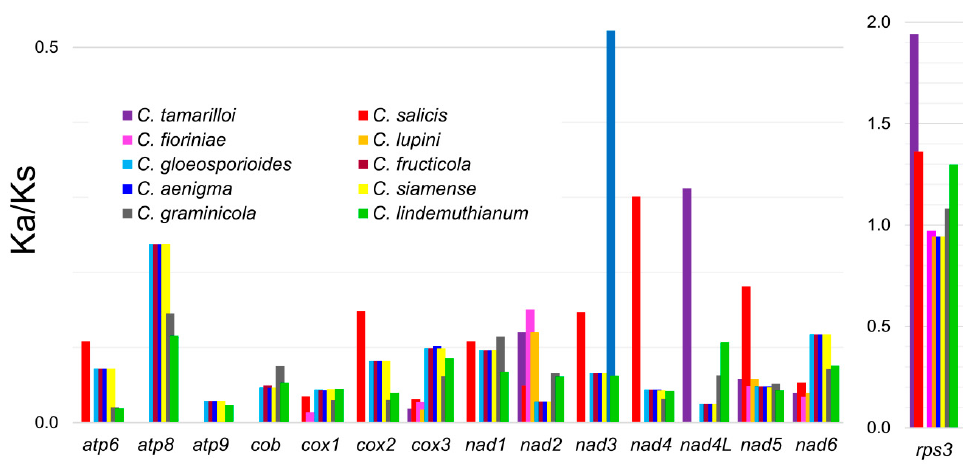
Figure 2. The distribution of non-synonymous (Ka) to synonymous (Ks) substitutions ratio among 15 protein-coding mitochondrial genes of eleven Colletotrichum species, using C. acutatum as reference genome. For rps3 , due to its highest variation, different Ka/Ks ratio scale was applied.